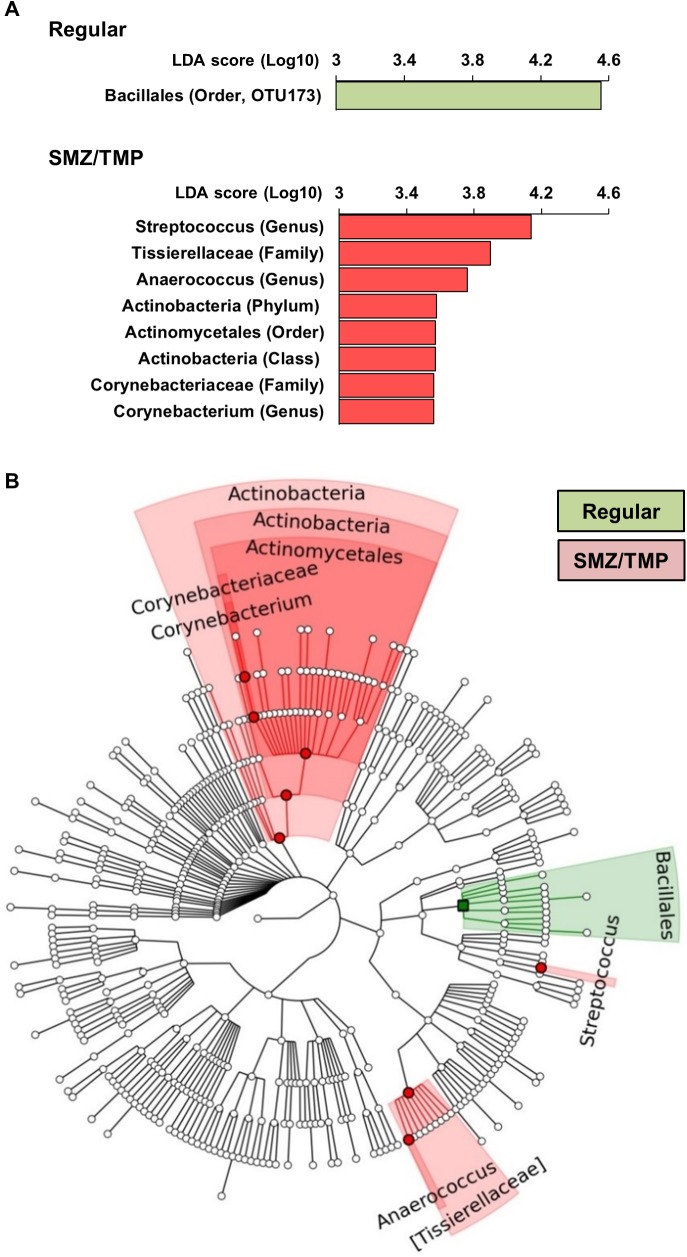
Gut-Microbiome changes induced by SMZ/TMP in Cxcr2-/- mice after RRV infection.(A) Bacterial taxa representing significantly different abundances between the regular (green) and SMZ/TMP (red) diets in Cxcr2-/- mice according to their LDA scores. (B) Cladograms were generated on the basis of the LDA scores, showing significantly different abundance between regular and SMZ/TMP diet. Green-highlighted regions are indicative of taxa more abundant in regular diet, and red-highlighted regions, more abundant in SMZ/TMP diet (N = 8–13 per group).